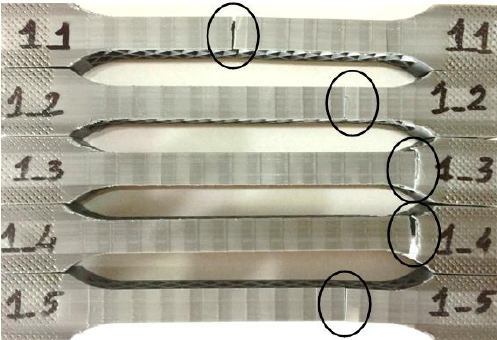
Figure 14. Failure modes of sandwich specimens under tensile load: face sheet yielding and core shear failure.